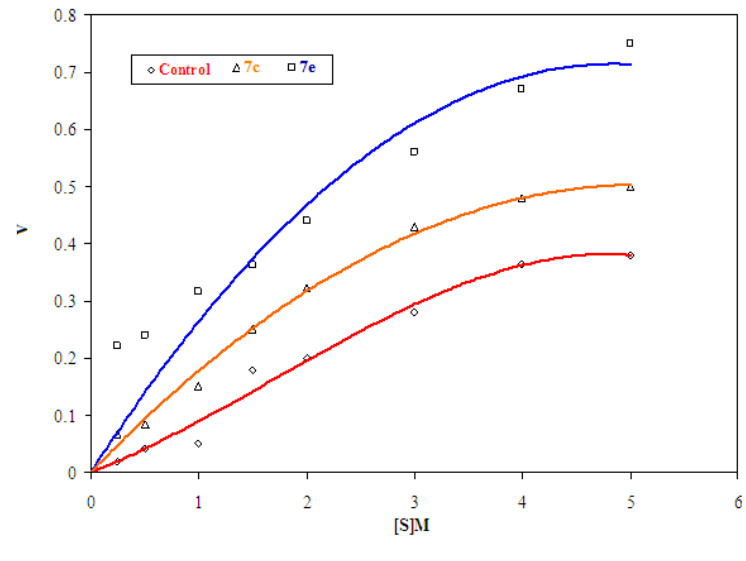
Figure 2. Effect of substrate concentration on the rate of MAO-B catalyzed reactions in the presence of the examined compounds 7c,e compared to control.